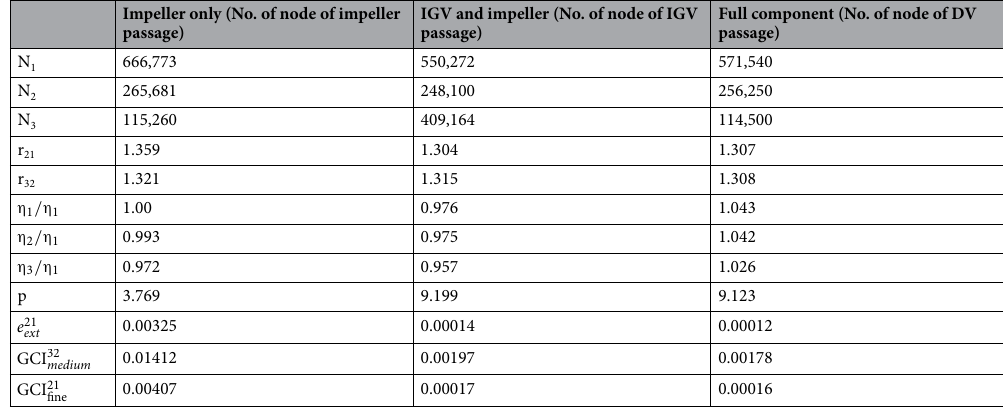
Table 3. Grid independence test.